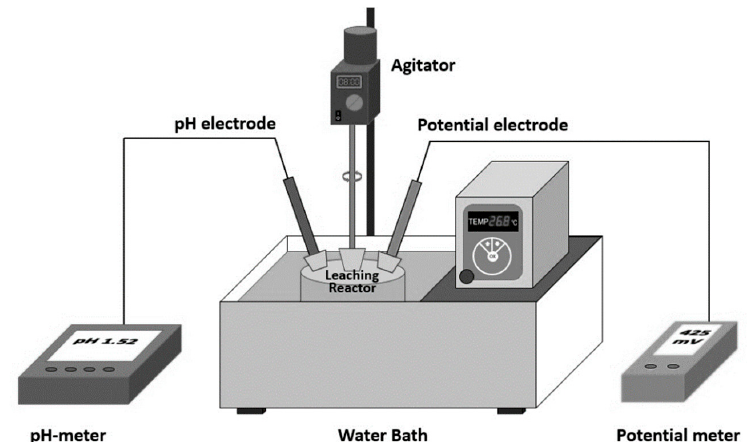
Figure 1. Experimental setup.